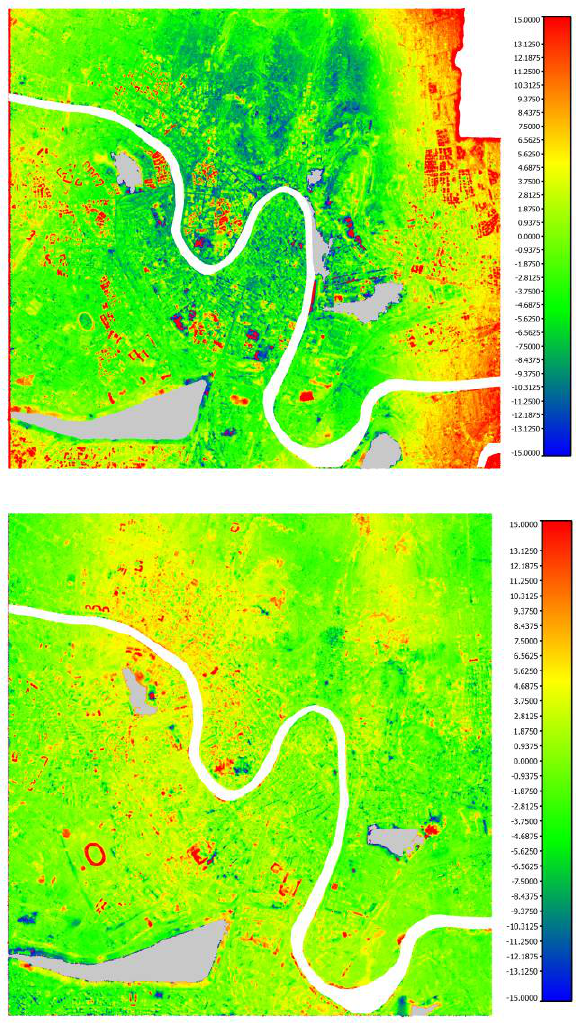
Figure 3: differences between 1981-1954. The maximum values in the scale are + 15 m and -15 m By analyzing the points highlighted in red or blue, some cases are particularly significant. In the first map the evidences are connected above all with new building and neighbourhoods (Figure 4). And also the area of the Bentegodi Stadium in the south west of Verona (Figure 5) shows a big transformation. The stadium was built in 1963 on an un-built area and in 1990, in occasion of the Football World Cup in Italy, a further ring was